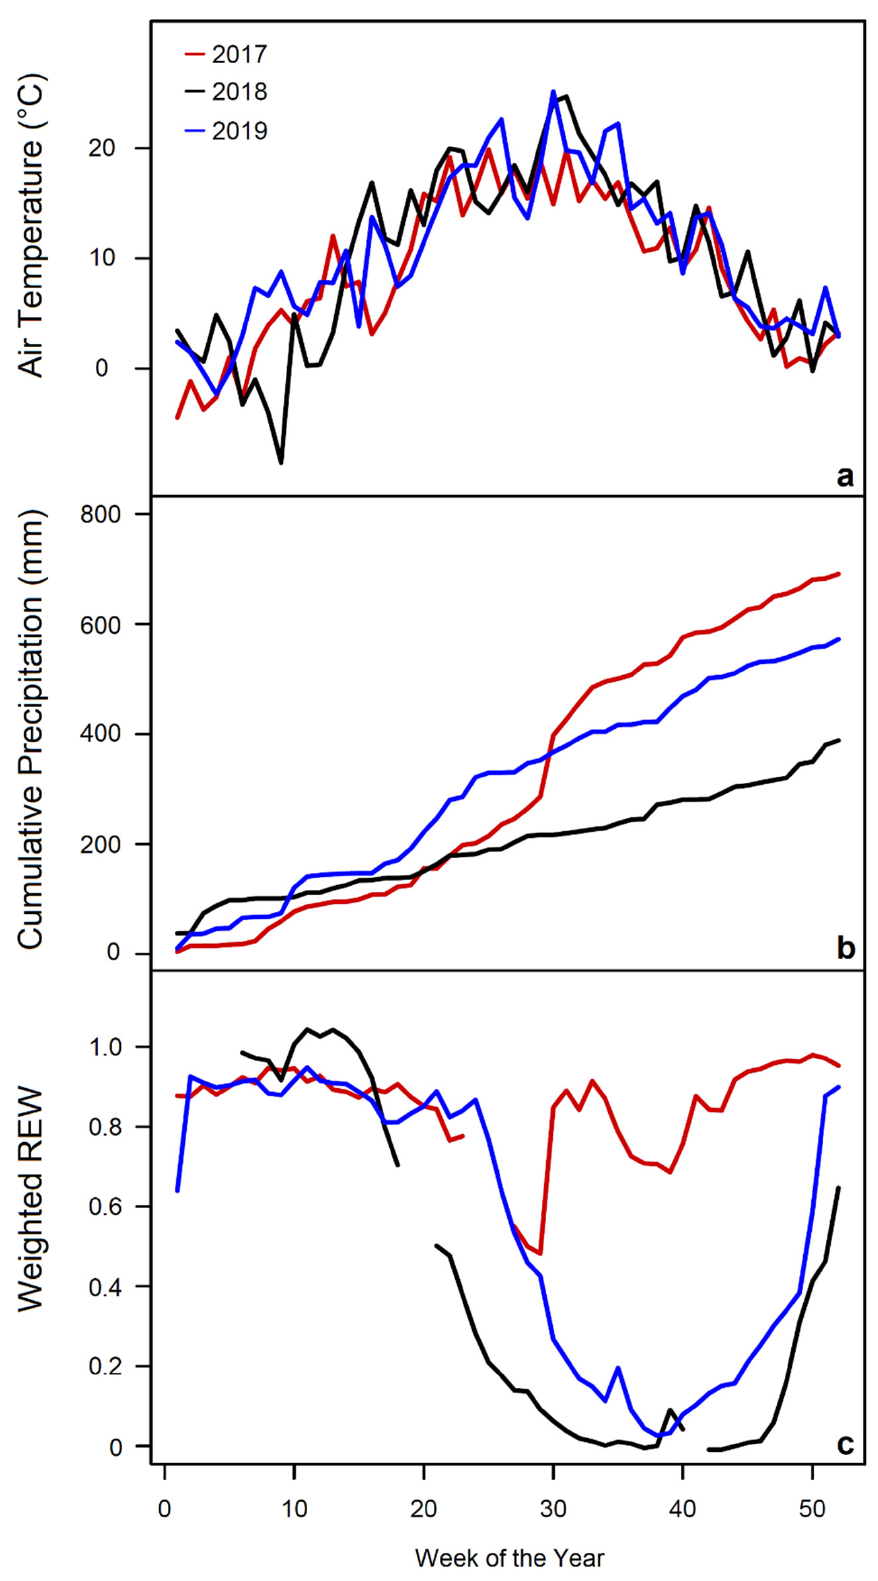
Figure 1. Weekly ( a ) average air temperature, ( b ) cumulative precipitation and ( c ) average soil volume weighted relative extractable water (REW) at the Leinefelde tower site for the year 2017 to 2019.